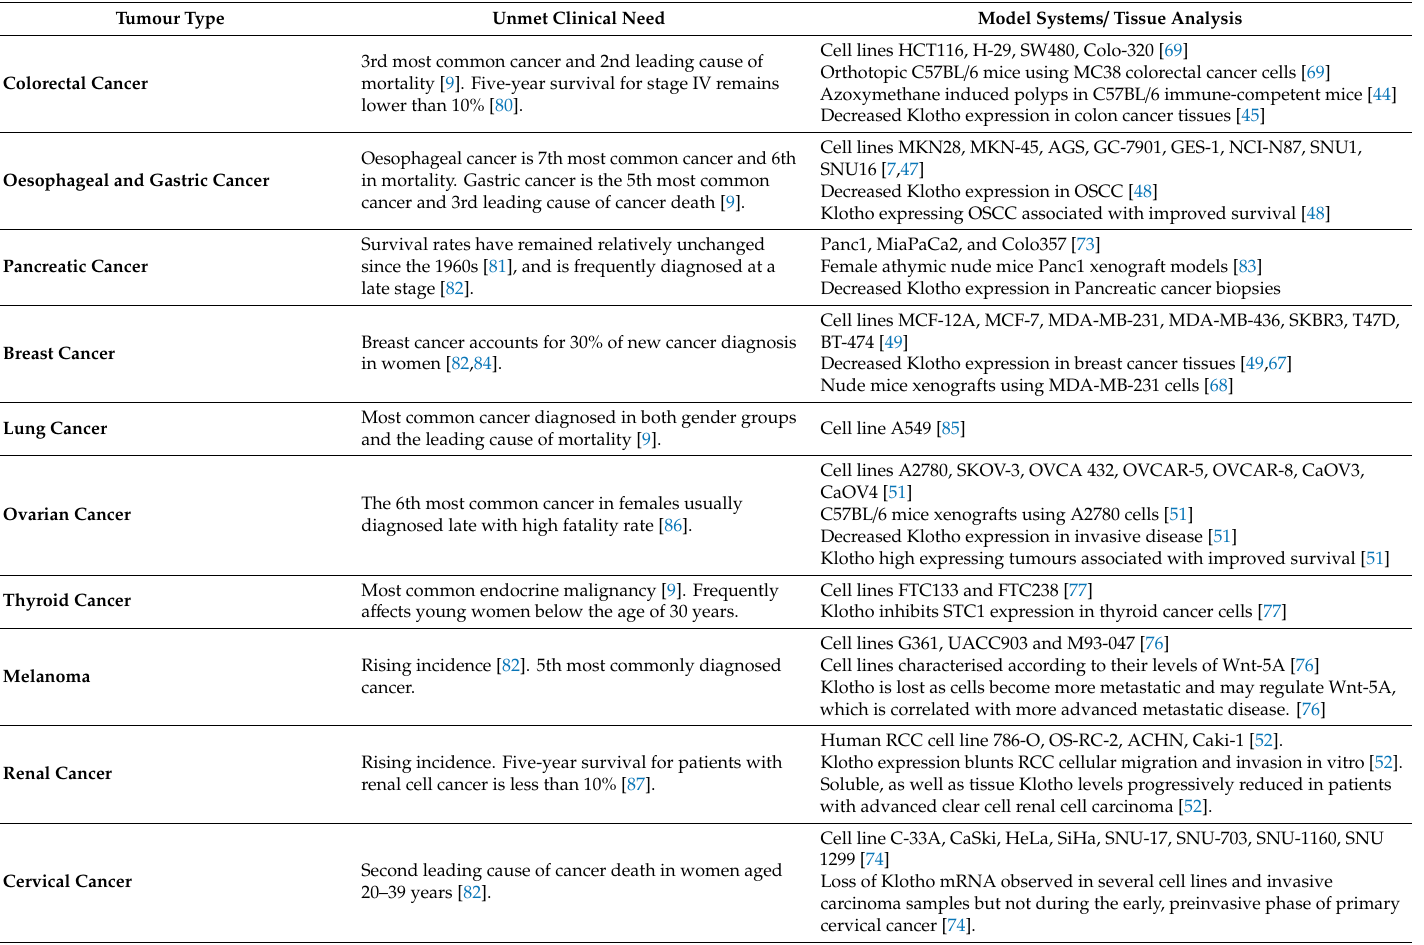
Table 1. Klotho is a tumour suppressor of human